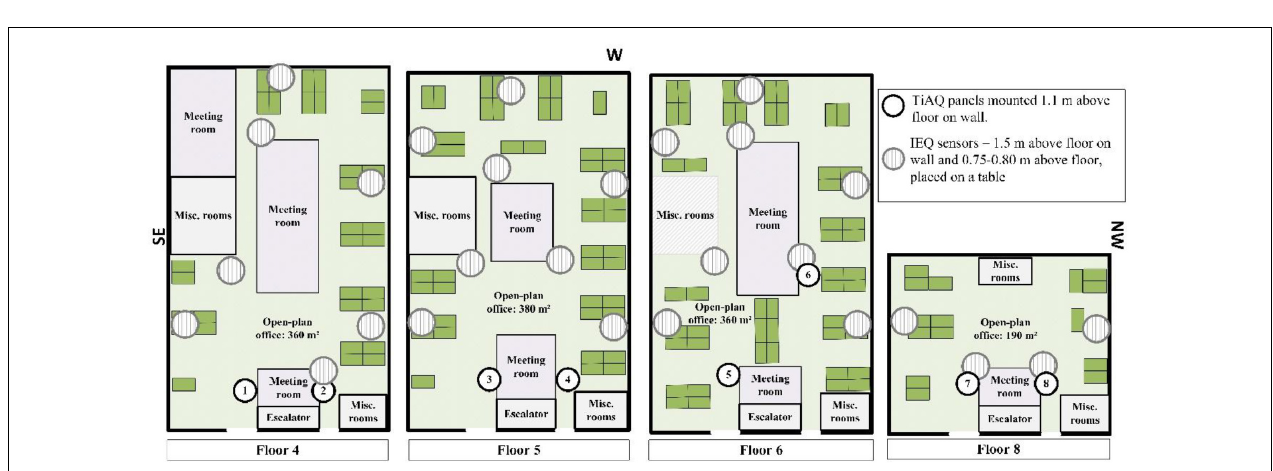
FIGURE 2 | Location of TiAQ, deployed sensors and desks. The first experiment was conducted using only one TiAQ panel located at the spot marked with #. (A) Northern part of building A. (B) Southern part of building B.